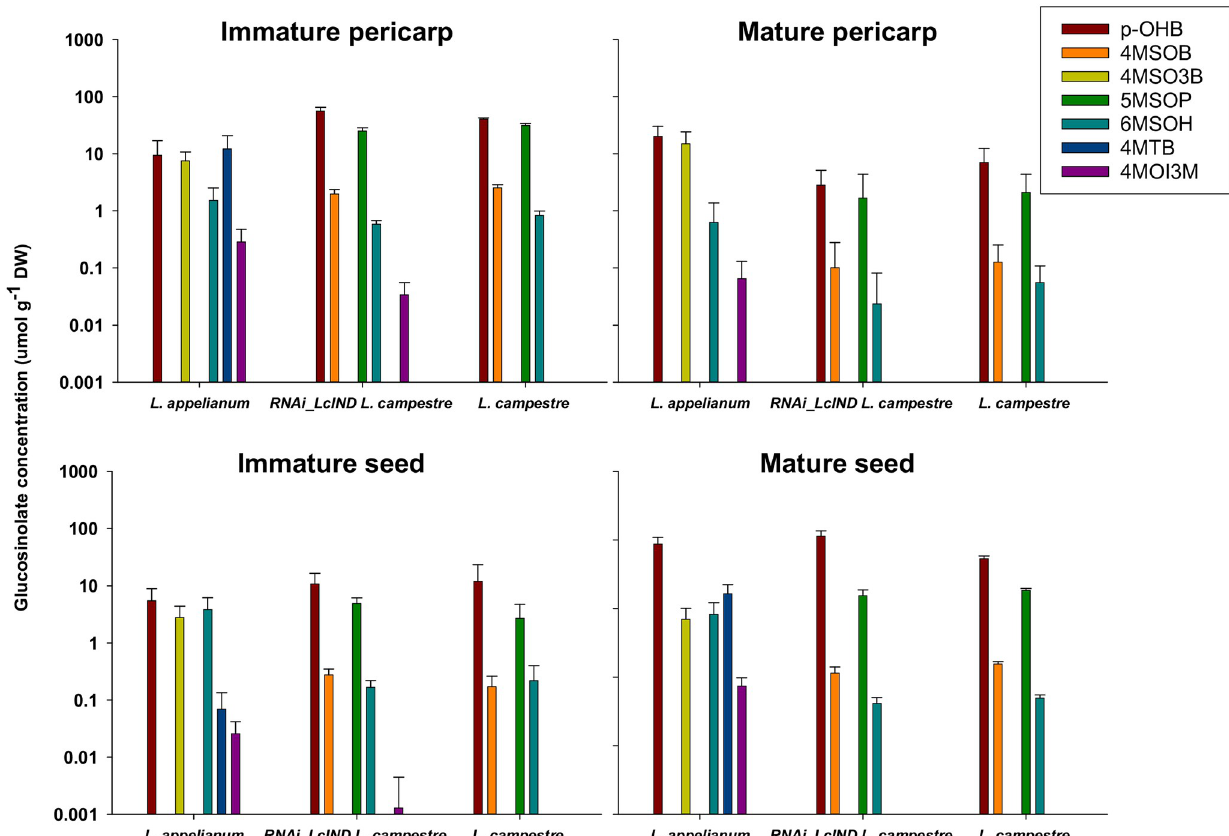
Fig 3. Distinct patterns of glucosinolate distribution in Lepidium diaspores. The mean concentrations ( μ mol/g DW, ± SE) of different glucosinolates (GSLs) measured in immature and mature pericarps and seeds of indehiscent ( L . appelianum , transgenic- RNAi- LcIND L . campestre ) and dehiscent ( L . campestre ) fruits are represented as column plots. The colour legends for the seven GSLs are indicated with the abbreviations: p-OHB, p -hydroxybenzyl GSL; 4MSOB, 4-methylsulfinylbutyl GSL; 4MSO3B, 4-methylsulfinyl-3-butenyl GSL; 5MSOP, 5-methylsulfinylpentyl GSL; 6MSOH, 6-methylsulfinylhexyl GSL; 4MTB, 4-methylthiobutyl GSL; 4MOI3M, 4-methoxy-indol-3-ylmethyl GSL.